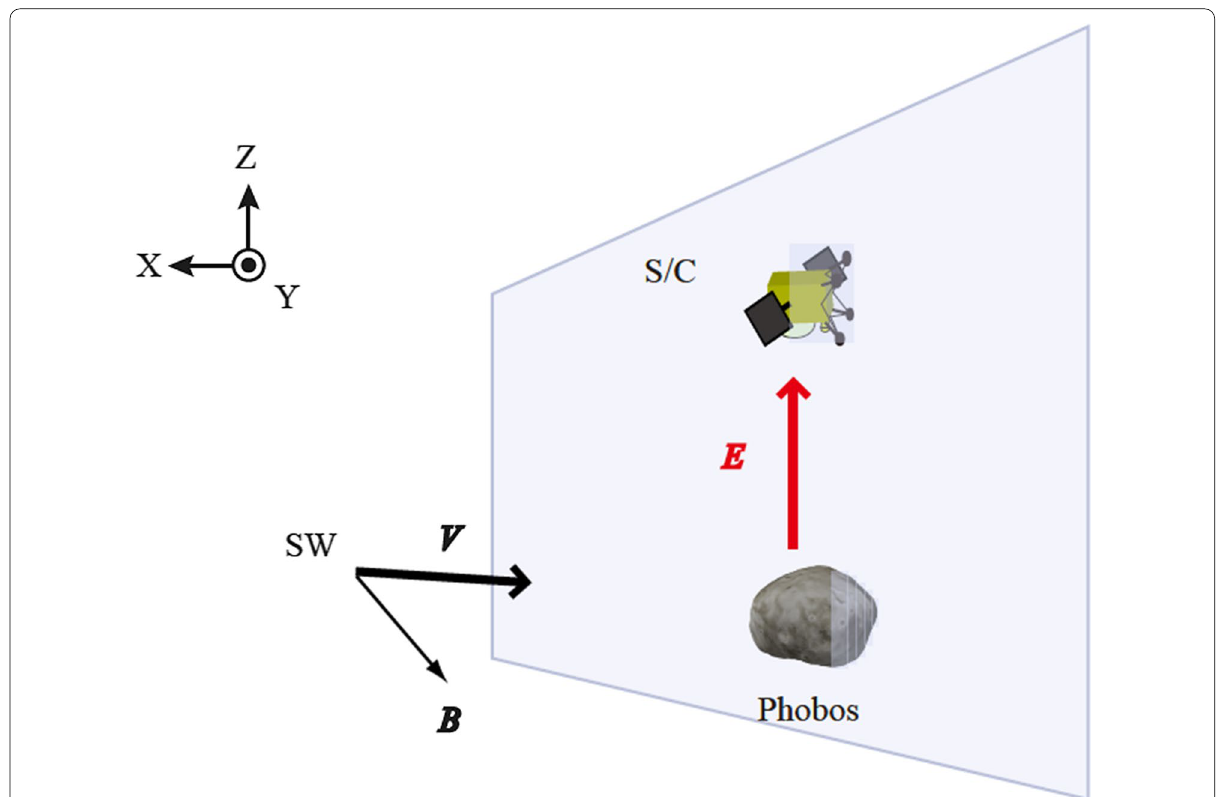
Fig. 7 Required observation configuration for the MSA observation 1 to measure secondary ions sputtered by the solar wind (SW) from Phobos surface, where V , B , and E indicate the velocity, and magnetic and electric fields of the SW, respectively. In the Phobos/Mars-centric Solar Ecliptic coordinate system, the direction of B is arbitrary, while V points approximately in the x direction. The secondary ions move along E = − V × B , because their initial energies are nearly 0. The magnetometer measures B , while E is derived from E = − V × B , where V denote the SW velocity measured by the ion analyzer. The spacecraft and Phobos are located in the same plane whose normal vector is